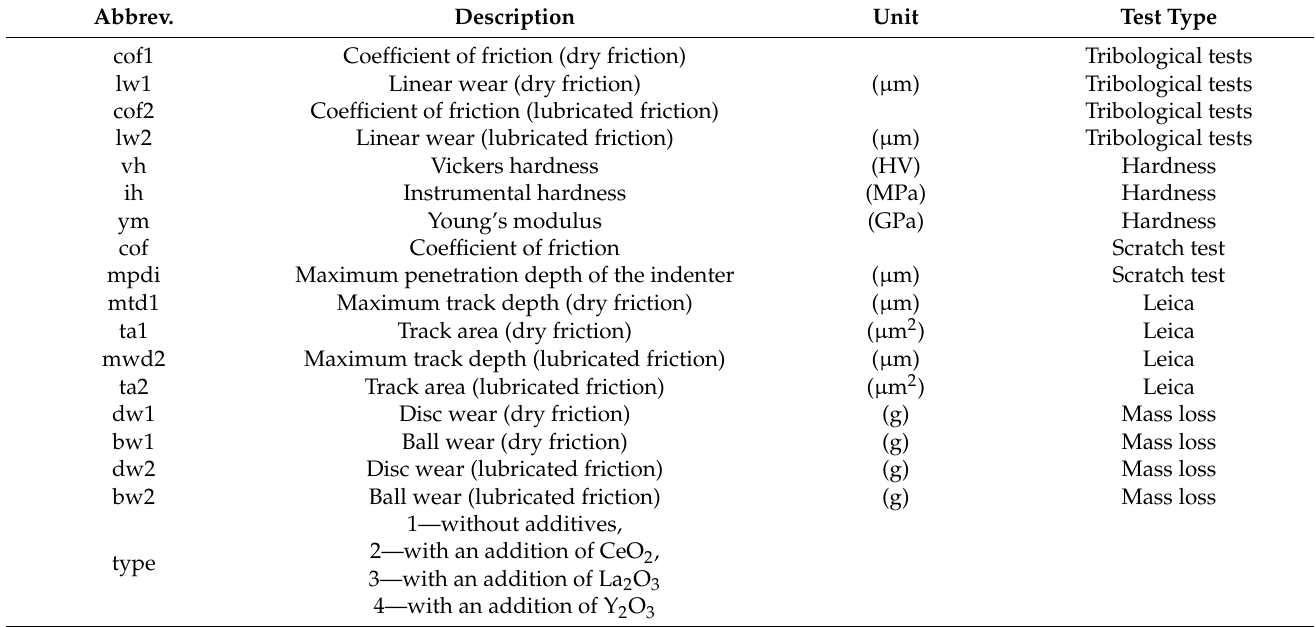
Table 2. Description of abbreviations.